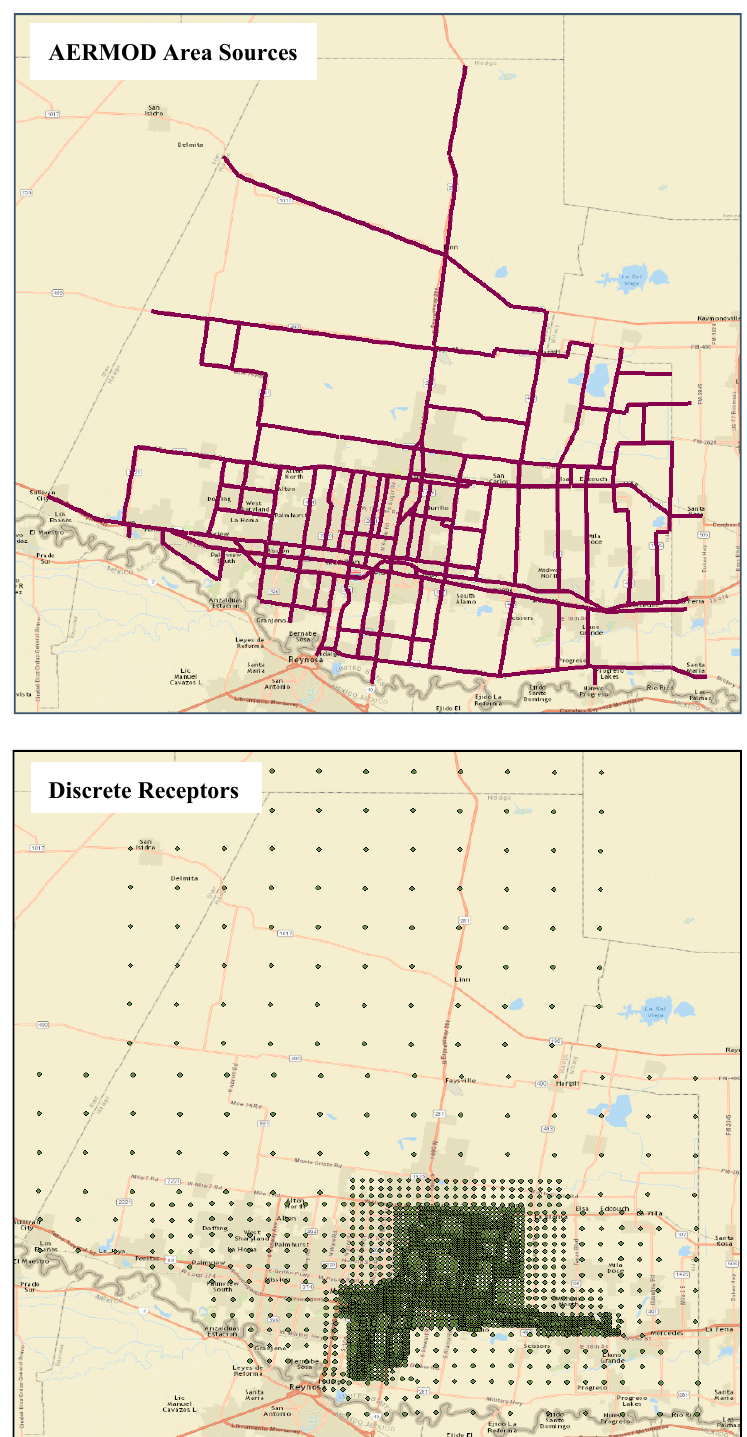
Figure 5. AERMOD emission source and receptor placement for case study site.